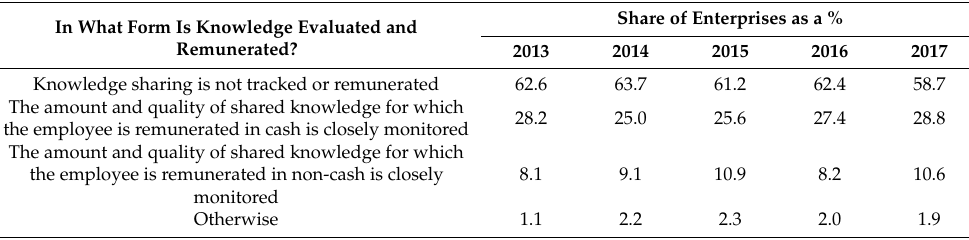
Table 6. Form of evaluation and remuneration of knowledge.